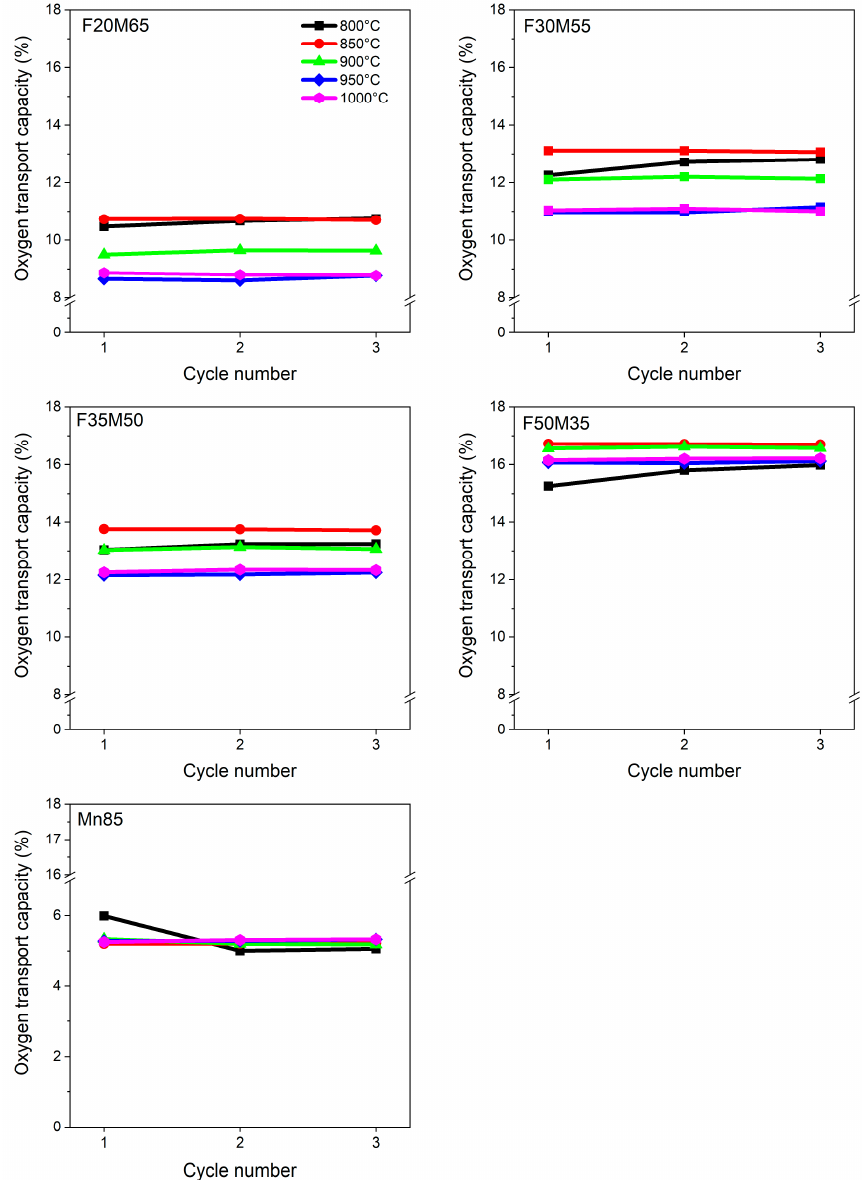
Figure 4. Experimental oxygen capacity versus cycle number for F20M65, F30M55, F35M50, F50M35, and M85 oxygen carriers.